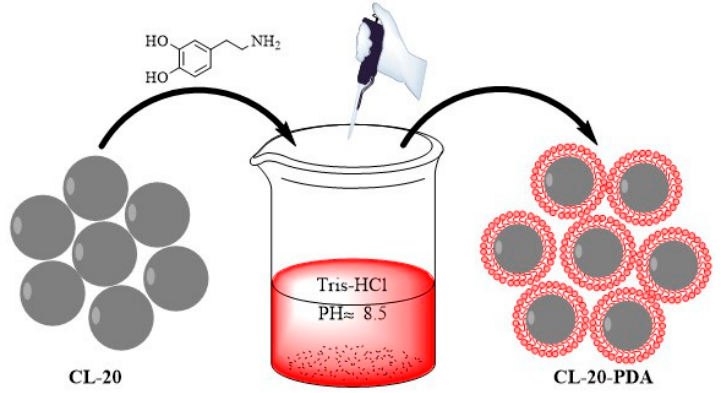
Figure 2. The schematic diagram of the preparation method of the core ‐ shell structure.